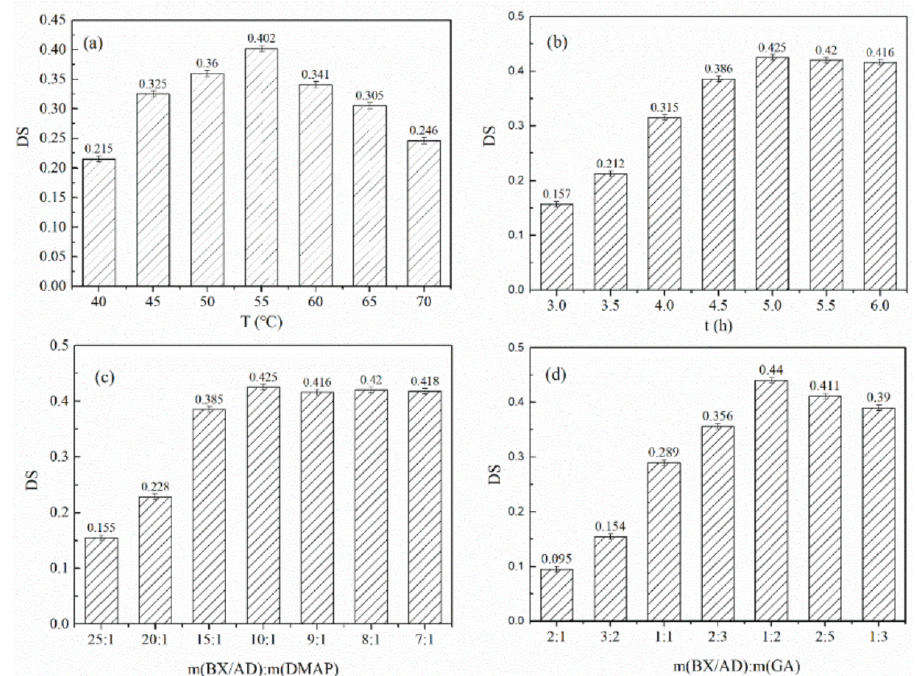
Figure 2. ( a ) Effect of reaction temperature on the DS . ( b ) Effect of reaction time on the DS . ( c ) Effect of catalyst dosage on the DS . ( d ) Effect of glycyrrhetinic acid dosage on the DS